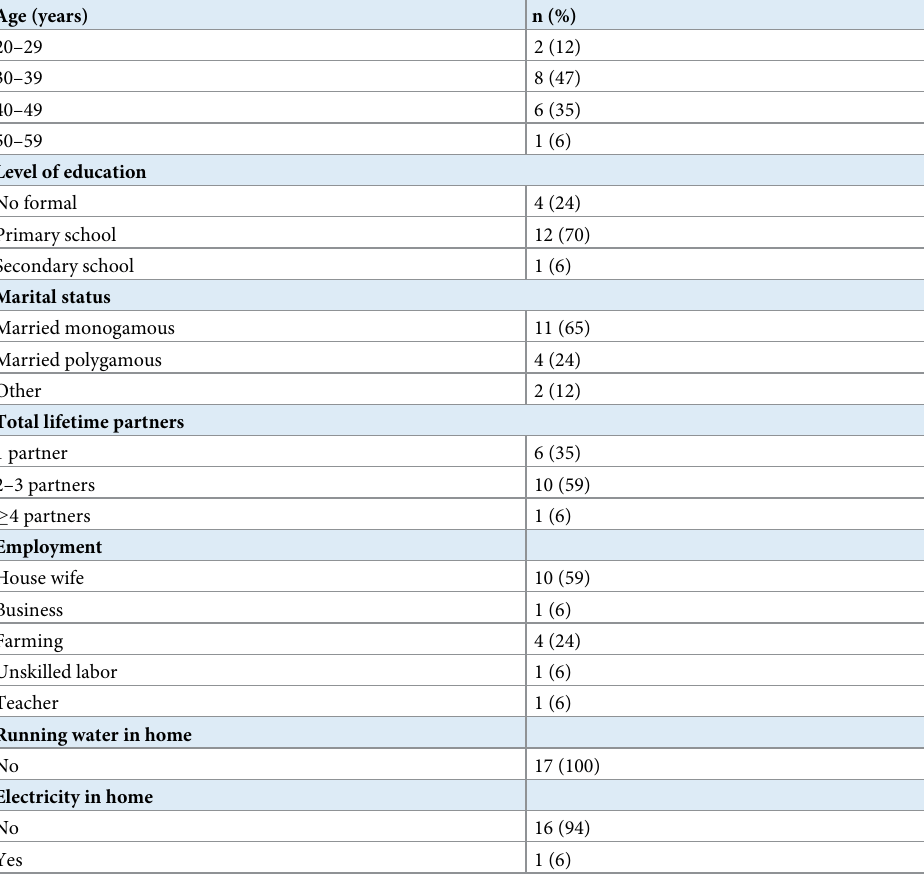
Table 1. Demographic characteristics of participants (N =